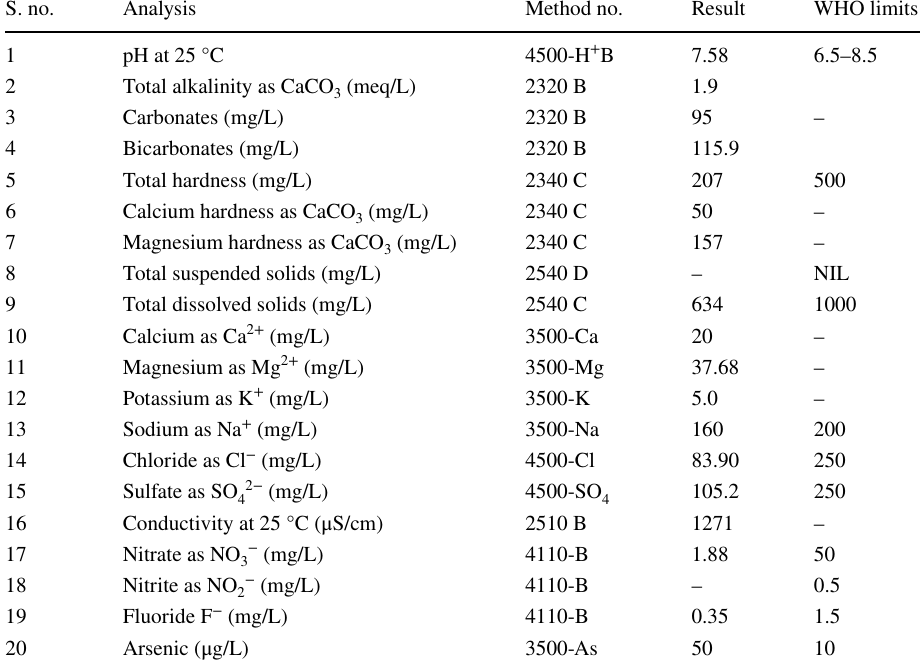
S. no. Analysis Method